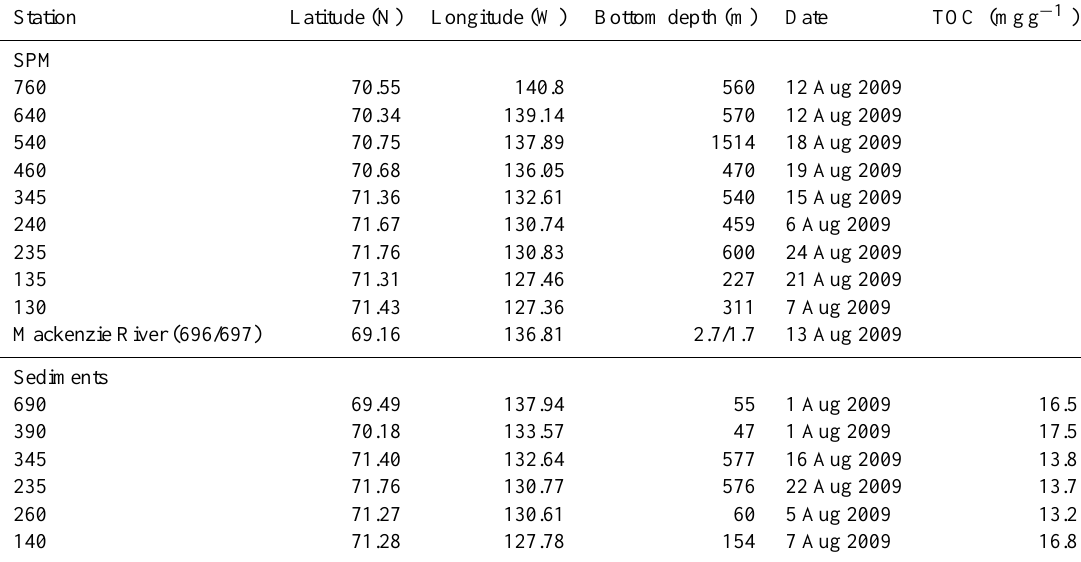
Table 1. List of stations where sampling of suspended particulate matter (SPM) and sediments were conducted. For sediment samples, total organic carbon (TOC) is also